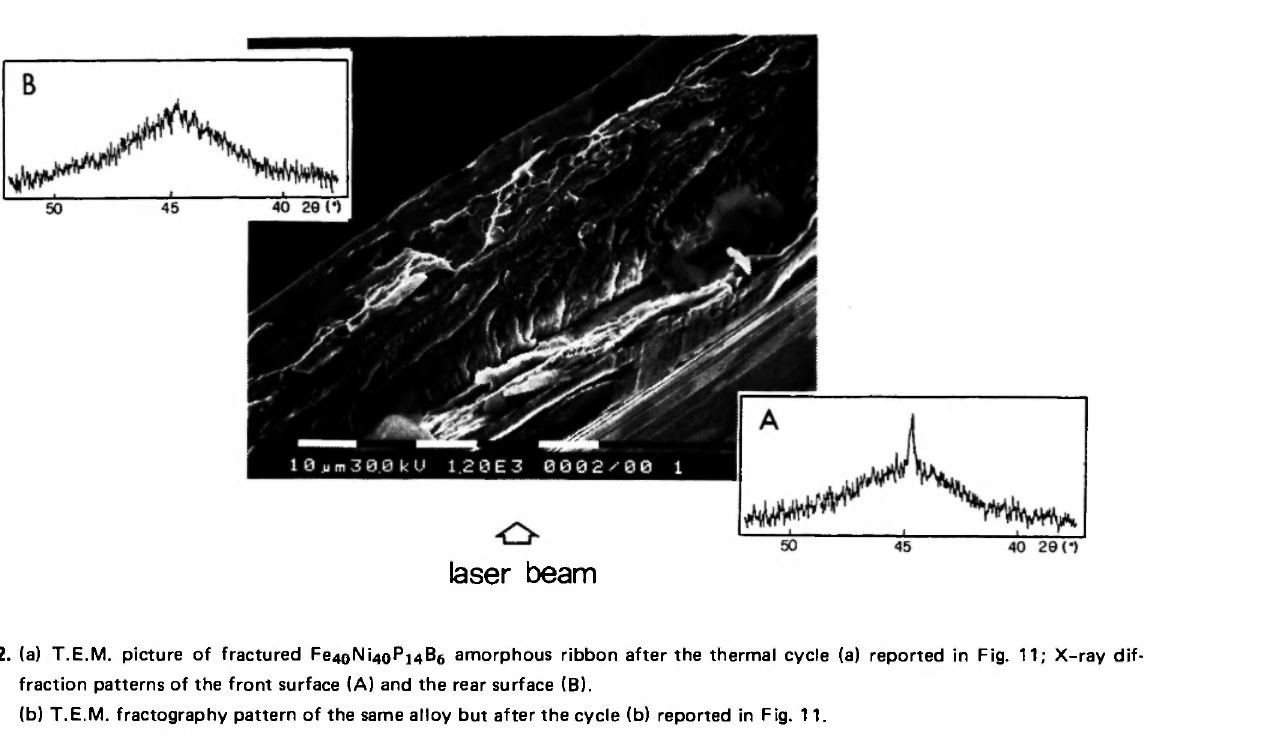
Fig. 12. (a) T.E.M. picture of fractured Fe4oNi4oPi4B6 amorphous ribbon after the thermal cycle (a) reported in Fig. 11; X-ray dif- fraction patterns of the front surface (A) and the rear surface (B). (b) T.E.M. fractography pattern of the same alloy but after the cycle (b) reported in Fig. 11.